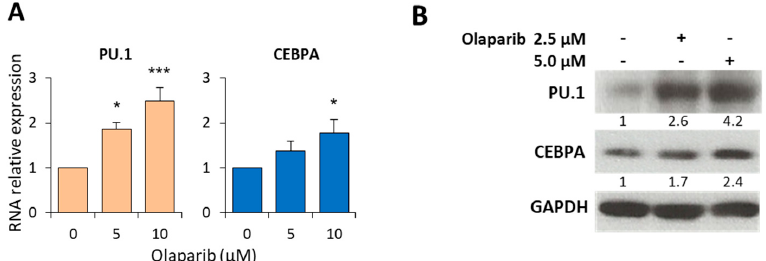
Figure 5. Olaparib modulates the expression of transcription factors associated with myeloid di ff erentiation. ( A ) PU.1 and CEBPA mRNA expression were evaluated by qRT-PCR after 7 days of culture and treatment with 5 or 10 µ M olaparib. Histograms show the mean ± SD relative expression in six MDS samples. Statistical analysis by Kruskal-Wallis followed by Dunn’s test: * p < 0.05, *** p < 0.001. ( B ) Representative immunoblot showing PU.1 and CEBPA protein expression from one MDS